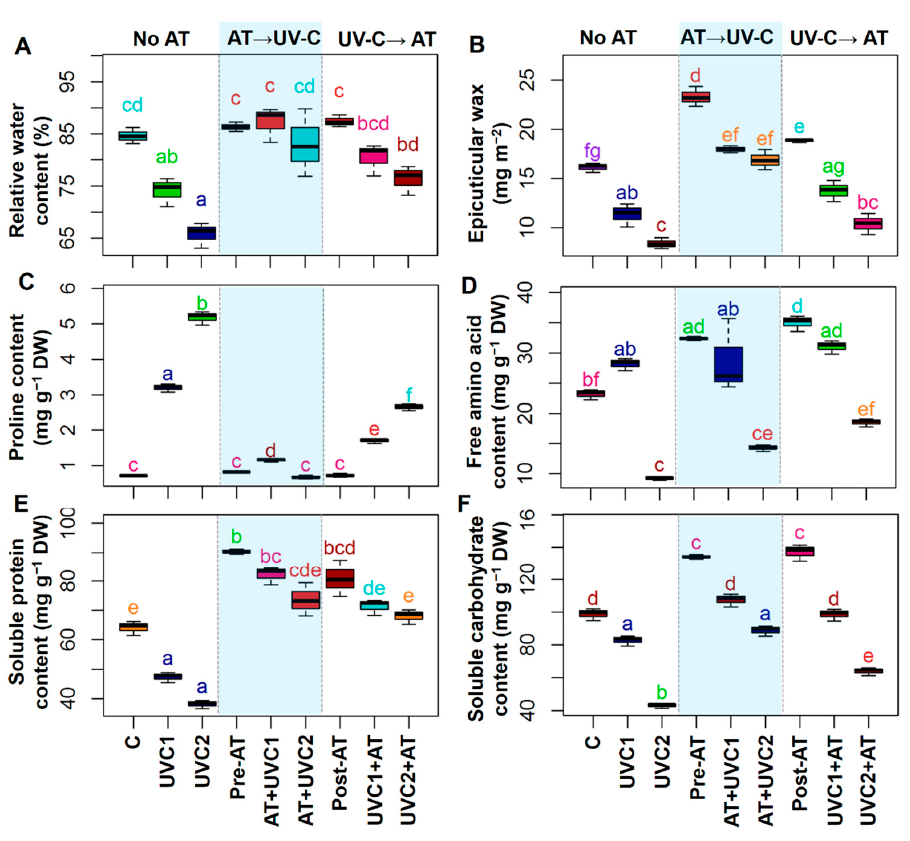
Figure 1. Effects of pre-treatment and post-treatment of allantoin (AT) on the relative water (RWC) content ( A ), epicuticular wax ( B ), proline (Pro) content ( C ), free amino acid (FAA) content ( D ), soluble protein (SP) content ( E ), and soluble carbohydrate (SC) content ( F ) in tomato plants grown 15 days in presence and absence of UVC stress. Each boxplot shows values of five independent replicates ( n = 5). Boxplots specified with the same letter(s) are statistically non-significant at p < 0.05 based on Tukey’s test. ”C”, no AT and grown under non-stress condition; ”UVC1”, exposed to 0.6 W m − 2 UVC irradiation; ”UVC2”, exposed to 1.2 W m − 2 UVC irradiation; ”Pre-AT”, pre- treated with 100 nM AT and thereafter exposed to 0 W m − 2 UVC irradiation; ”AT+UVC1”, pre- treated with 100 nM AT and after that exposed to 0.6 W m − 2 UVC irradiation; ”AT+UVC2”, pre- treated with 100 nM AT and after that exposed to 1.2 W m − 2 UVC irradiation; ”Post-AT”, exposed to 0 W m − 2 UVC irradiation and thereafter treated with 100 nM AT; ”UVC1+AT”, exposed to 0.6 W m − 2 UVC irradiation and thereafter treated with 100 nM AT; ”UVC2+AT”, exposed to 1.2 W m − 2 UVC irradiation and after that treated with 100 nM AT. 2.4. AT Attenuated Oxidative Damage Exposure of tomato plants to UVC stress displayed a sharp increase in O 2• − , • OH, H 2 O 2 , malondialdehyde (MDA), and MG in both ”UVC1” and ”UVC2” plants and lipox- ygenase (LOX) activity in ”UVC2” plants (Figure 2) compared with that of ”C” plants. Pre-treatment of AT significantly decreased O 2• − , • OH, H 2 O 2 , MDA, LOX activity, and MG content in the leaves of ”AT+UVC1” and ”AT+UVC2” plants, respectively, compared to that found in the corresponding ”UVC1” and ”UVC2” plants (Figure 2). Post-treatment of AT significantly reduced O 2• − and • OH in ”UVC1+AT” plants and H 2 O 2 , MDA, LOX, and MG in ”UVC2+AT” plants compared to that found in the corresponding ”UVC1” and ”UVC2” plants (Figure 2).